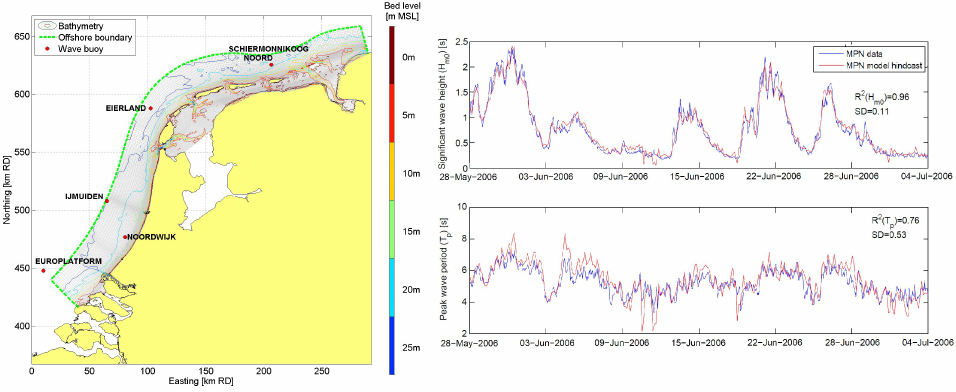
Figure 4. SWAN model domain for the derivation of nearshore wave boundary conditions. Wave measurement stations are shown as red